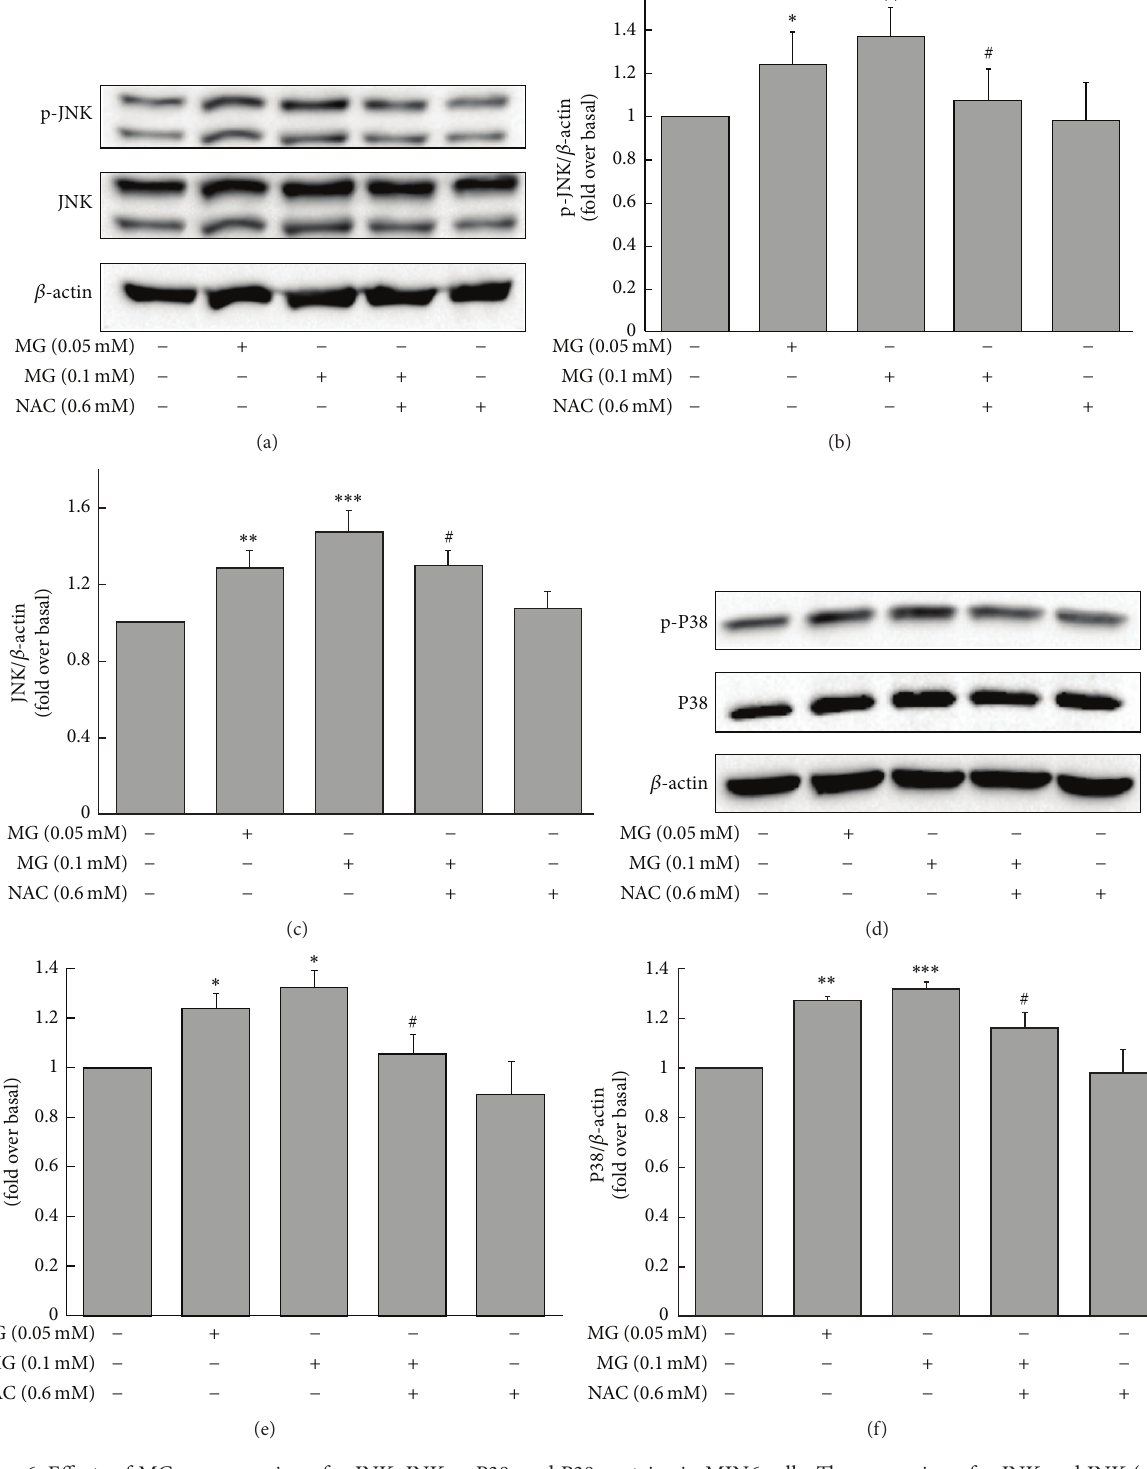
Figure 6: Effects of MG on expression of p-JNK, JNK, p-P38, and P38 proteins in MIN6 cells. The expression of p-JNK and JNK (a) and p-P38 and P38 (d) was increased by MG. Cells were incubated with 0.05 or 0.1mM MG for 3h. Results shown in (b), (c), (e), and (f) are fold change compared to baseline (0mM MG + 0 mM NAC). The effects of MG on MIN6 were reversed by coincubation with NAC. ∗ 𝑝 < 0.05 , ∗∗ 𝑝 < 0.01 , and ∗∗∗ 𝑝 < 0.001 compared to control group (0mM MG + 0 mM NAC). # 𝑝 < 0.05 compared to the higher MG group (0.1mM MG + 0 mM